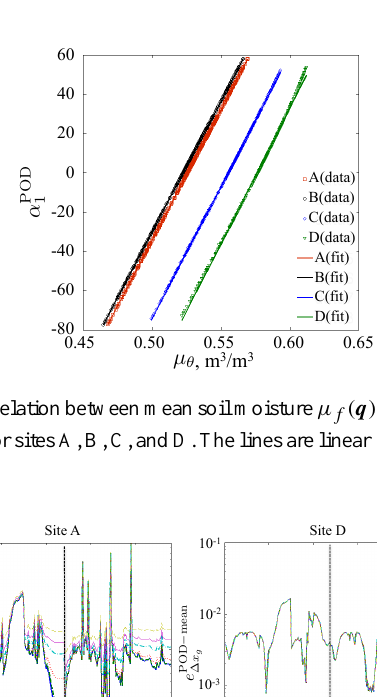
Figure 5. POD-mean error ( e POD - mean 2002 and 2006 for single-site ROM constructed using the POD- mean method.